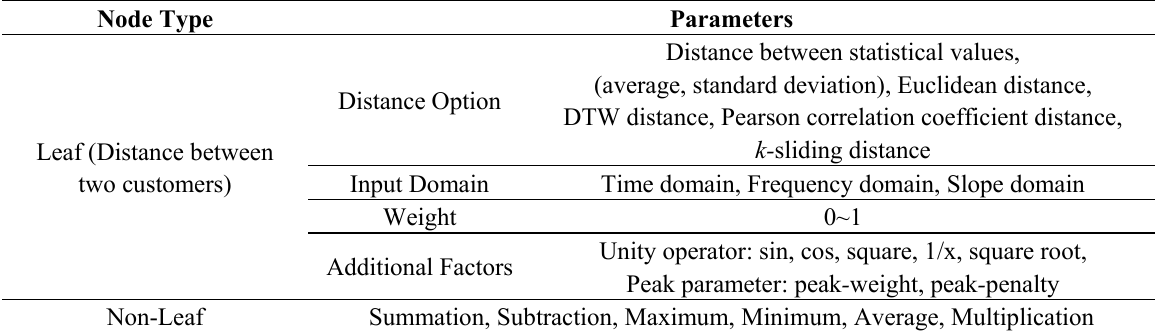
Table 2. Parameters of nodes in genetic